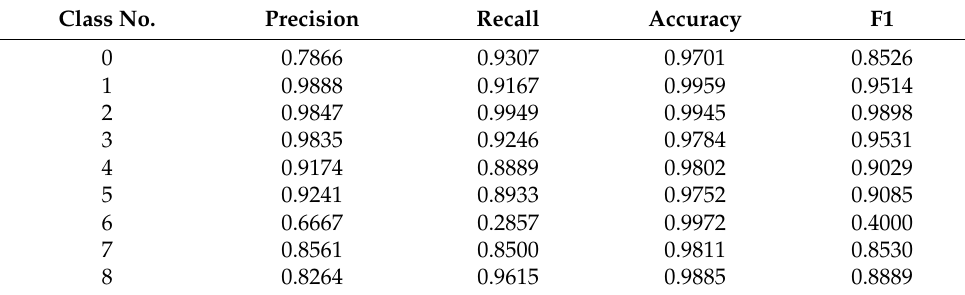
Table 2. Results of the training of Le-net5 on MMCC dataset. Class No. Precision